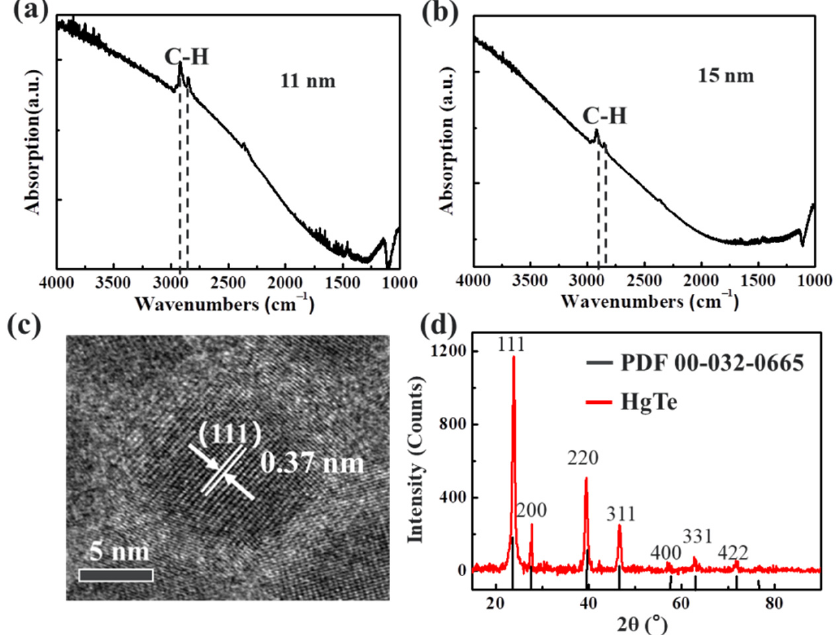
Figure 3. Absorption spectra of 11 nm ( a ), 15 nm ( b ) HgTe CQDs; ( c ) HRTEM image of HgTe CQDs; ( d ) XRD spectrum with labeled bulk HgTe diffraction angles.